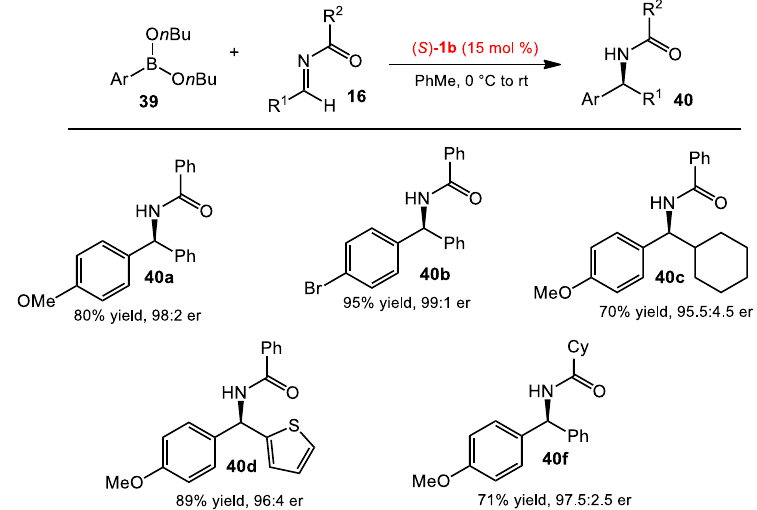
Scheme 14. Asymmetric arylboration of acyl imines.